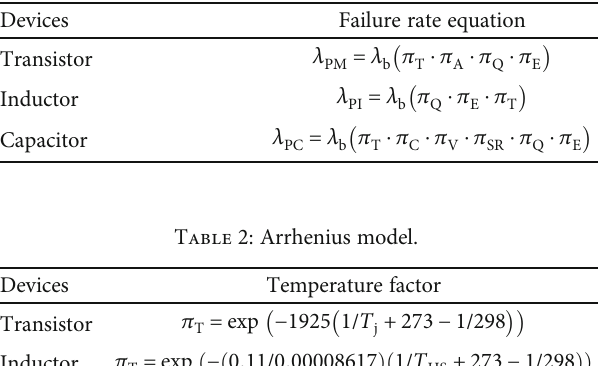
Figure 5: Full bridge with coupling L fi